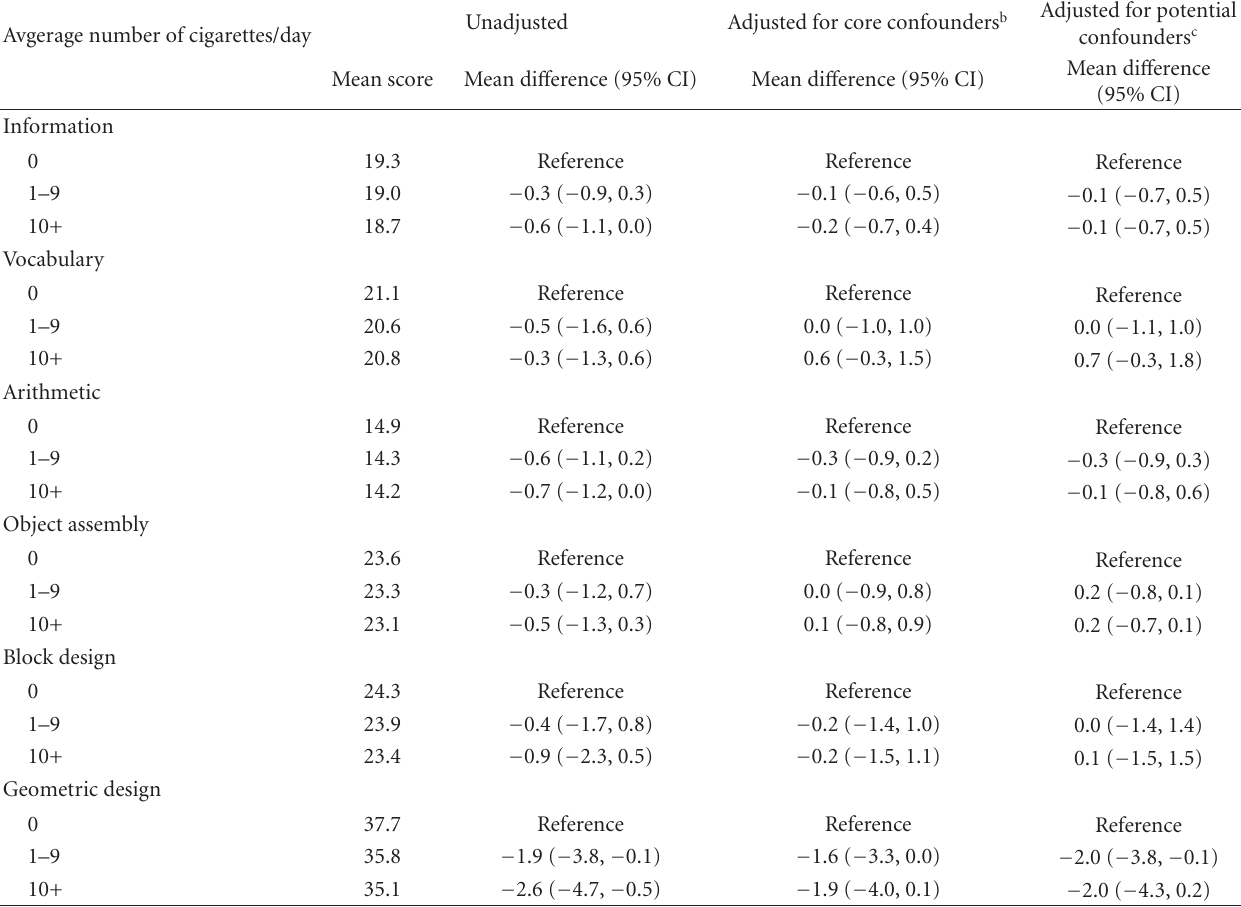
Table 4: Maternal smoking in pregnancy and WPPSI-R a subtest raw